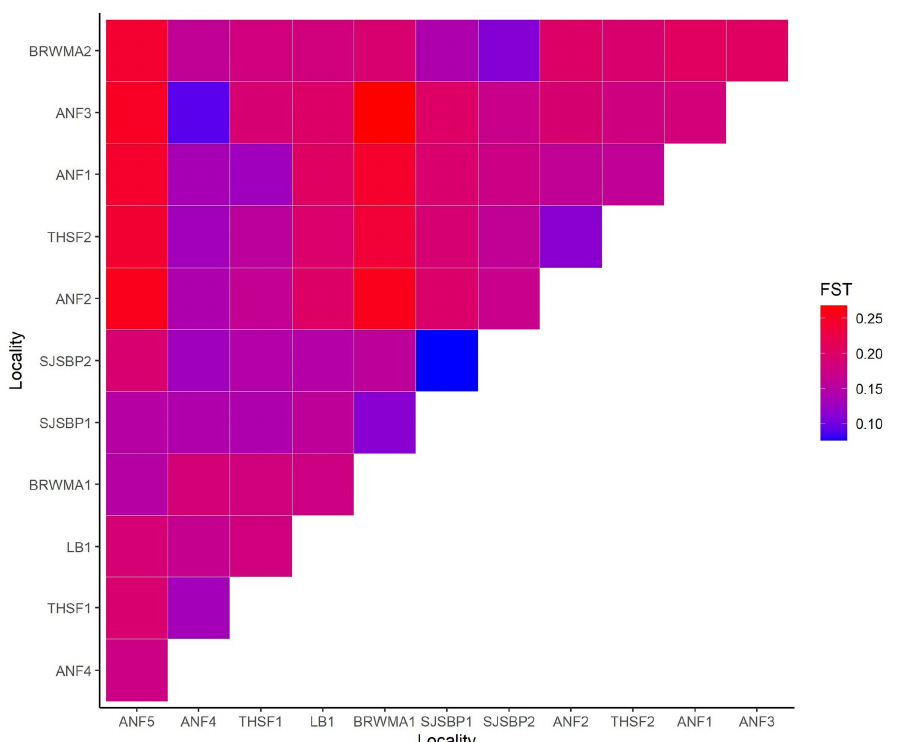
Figure 4. Heatmap visualizing pairwise F ST values for twelve populations across S. floridana ’s range.